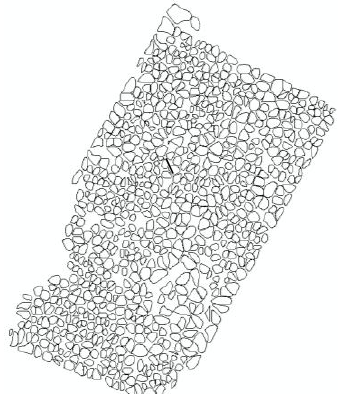
Figure 19. The final output of the algorithm